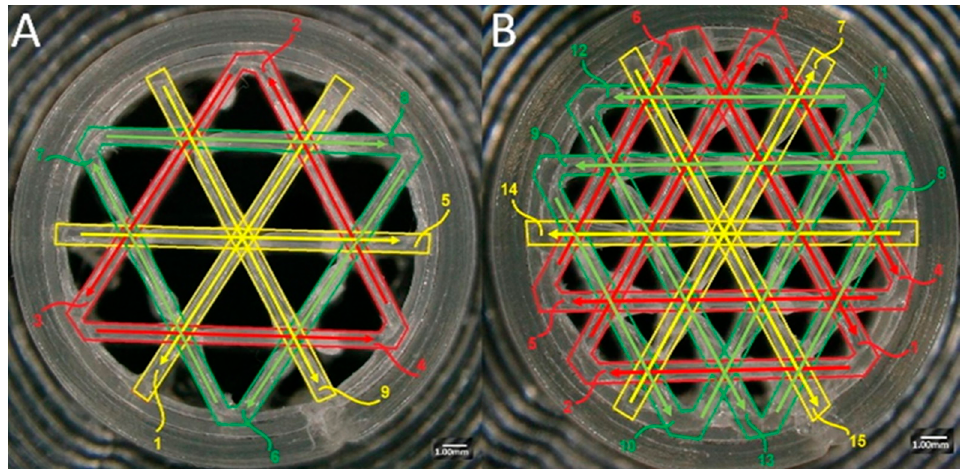
Figure 8. The movement path of the printer nozzle when printing: ( A ) 2.4 mm ILD sample, ( B ) 1.6 mm ILD sample.